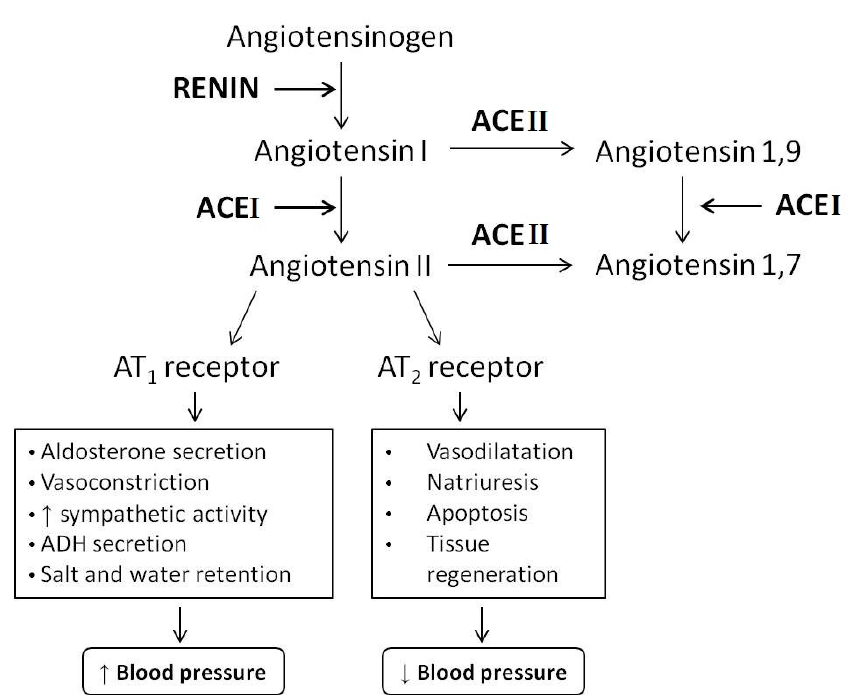
Figure 1. The renin-angiotensin system (RAS). ACEI: angiotensin I-converting enzyme; ACEII: angiotensin II-converting